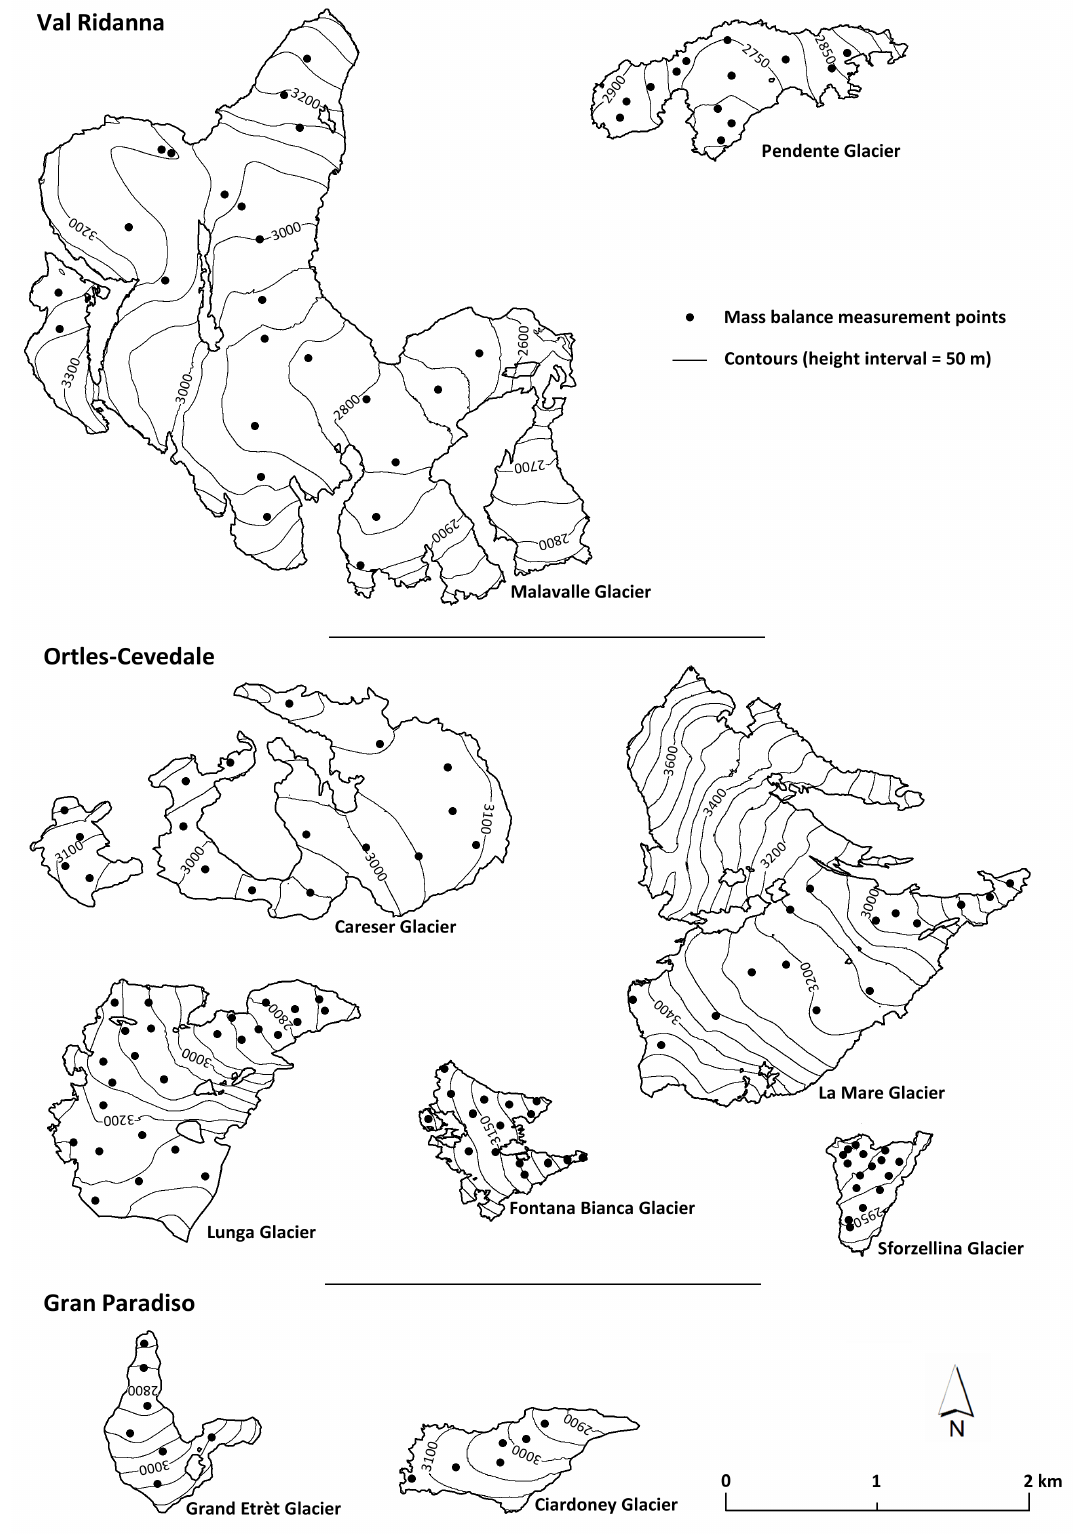
Figure 2. Surface topography and measurement network of the nine glaciers analyzed in this study.